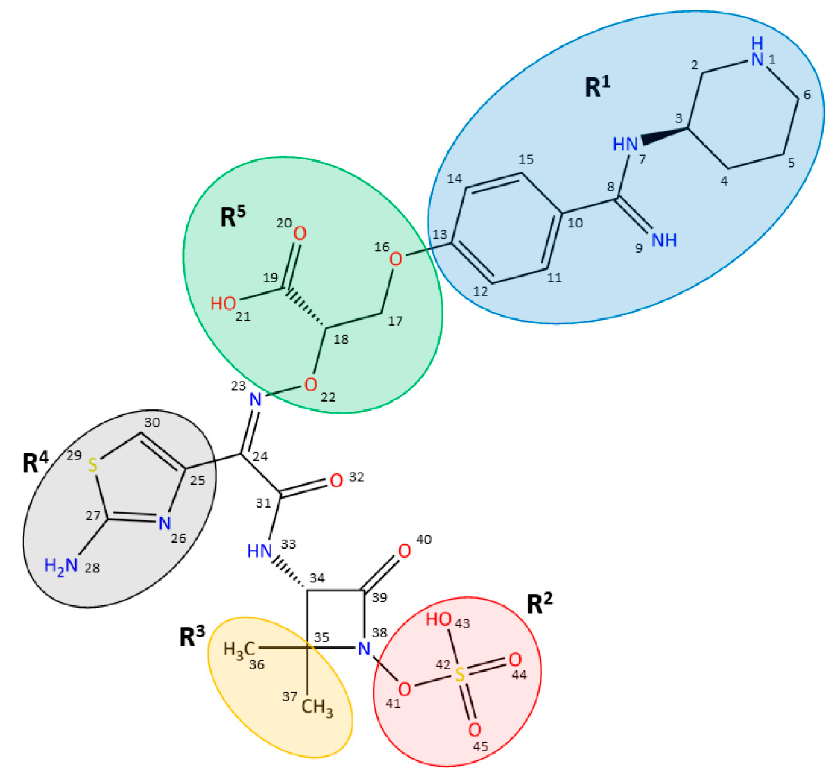
Figure 1. Structure of the monobactam AIC499, obtained by iterative optimization. The relevant functional groups are marked in color: benzamidine-based head group (R 1 ), blue; β -lactam N-1 position (R 2 ), red; β -lactam C-4 position (R 3 ), orange; amino-thiazole (R 4 ), gray; linker (R 5 ), green.